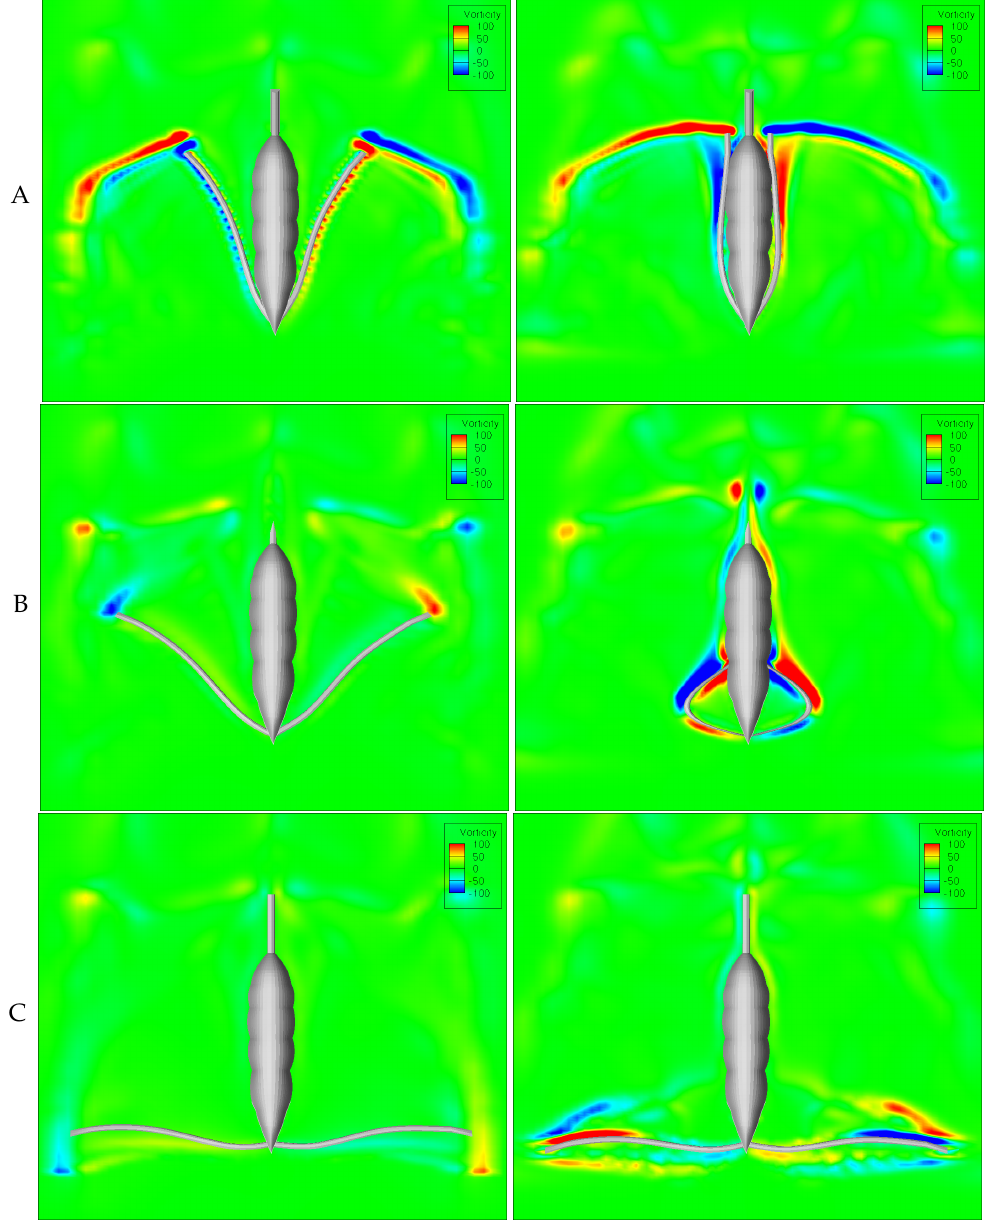
Figure 2. Out-of-plane vorticity contours for the top view mid plane of the copepod at ( A ) t/T = 0.33 ( B ) t/T = 0.66 ( C ) t/T = 1 for the rigid antennae ( left ) and deformable antennae ( right ) (Re = 300, T = 0.3). Reproduced with permission from [4]. See Video S1 in supplementary materials for a movie of the deformable